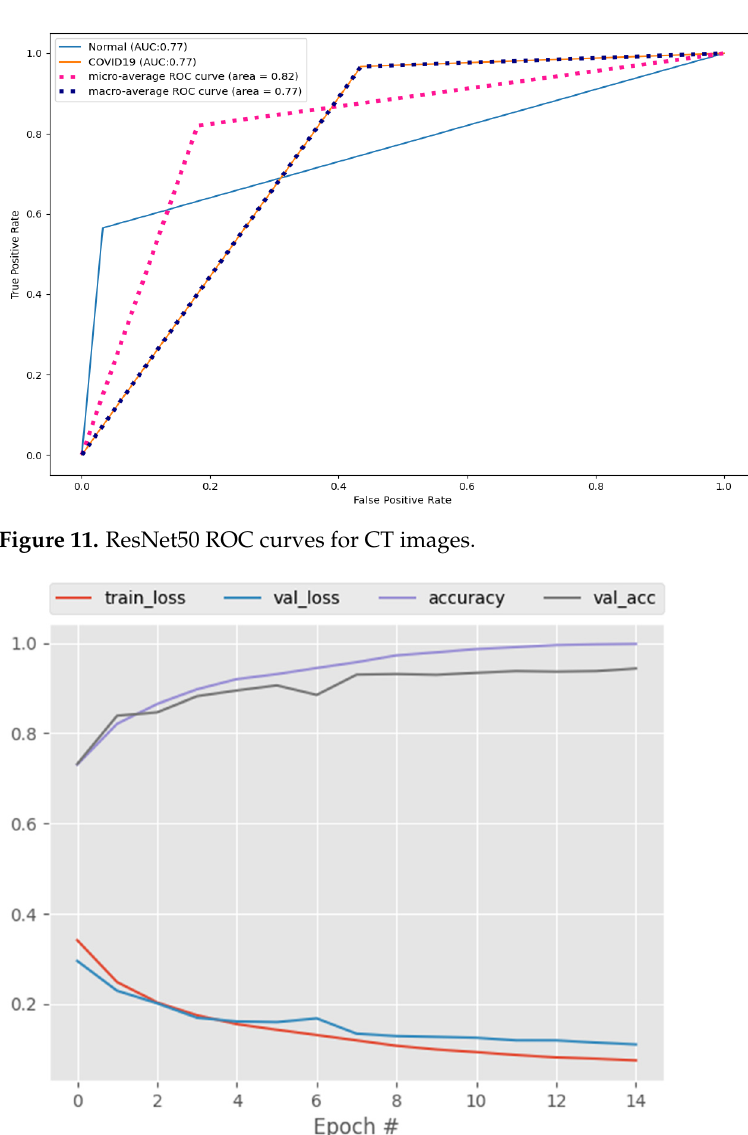
Figure 10. DesNet121 ROC curves for CT images.